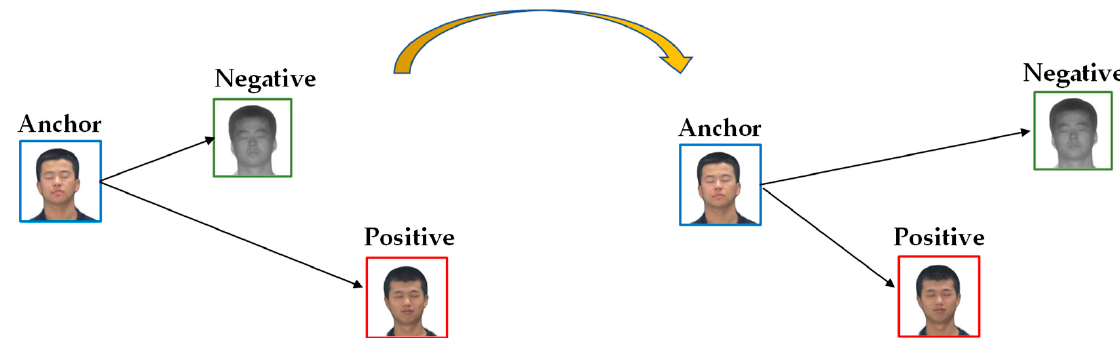
Figure 14. Schematic of a domain loss function based on a triplet loss function.